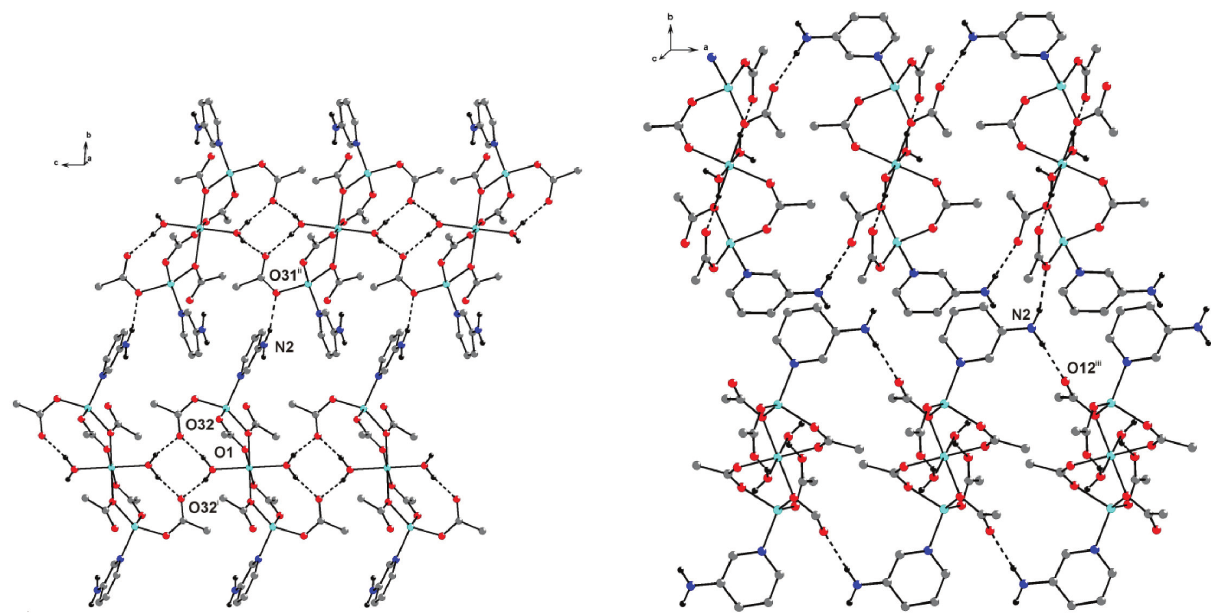
Figure 4. Hydrogen-bonding interactions in 1 . Formation of chains and layers (left) and arrangement the layers into 3D network (right). Symmetry codes: (i) – x + 1, – y + 1, – z + 2; (ii) x + 1/2, – y + 3/2, z – 1/2; (iii) x + 1, y , z